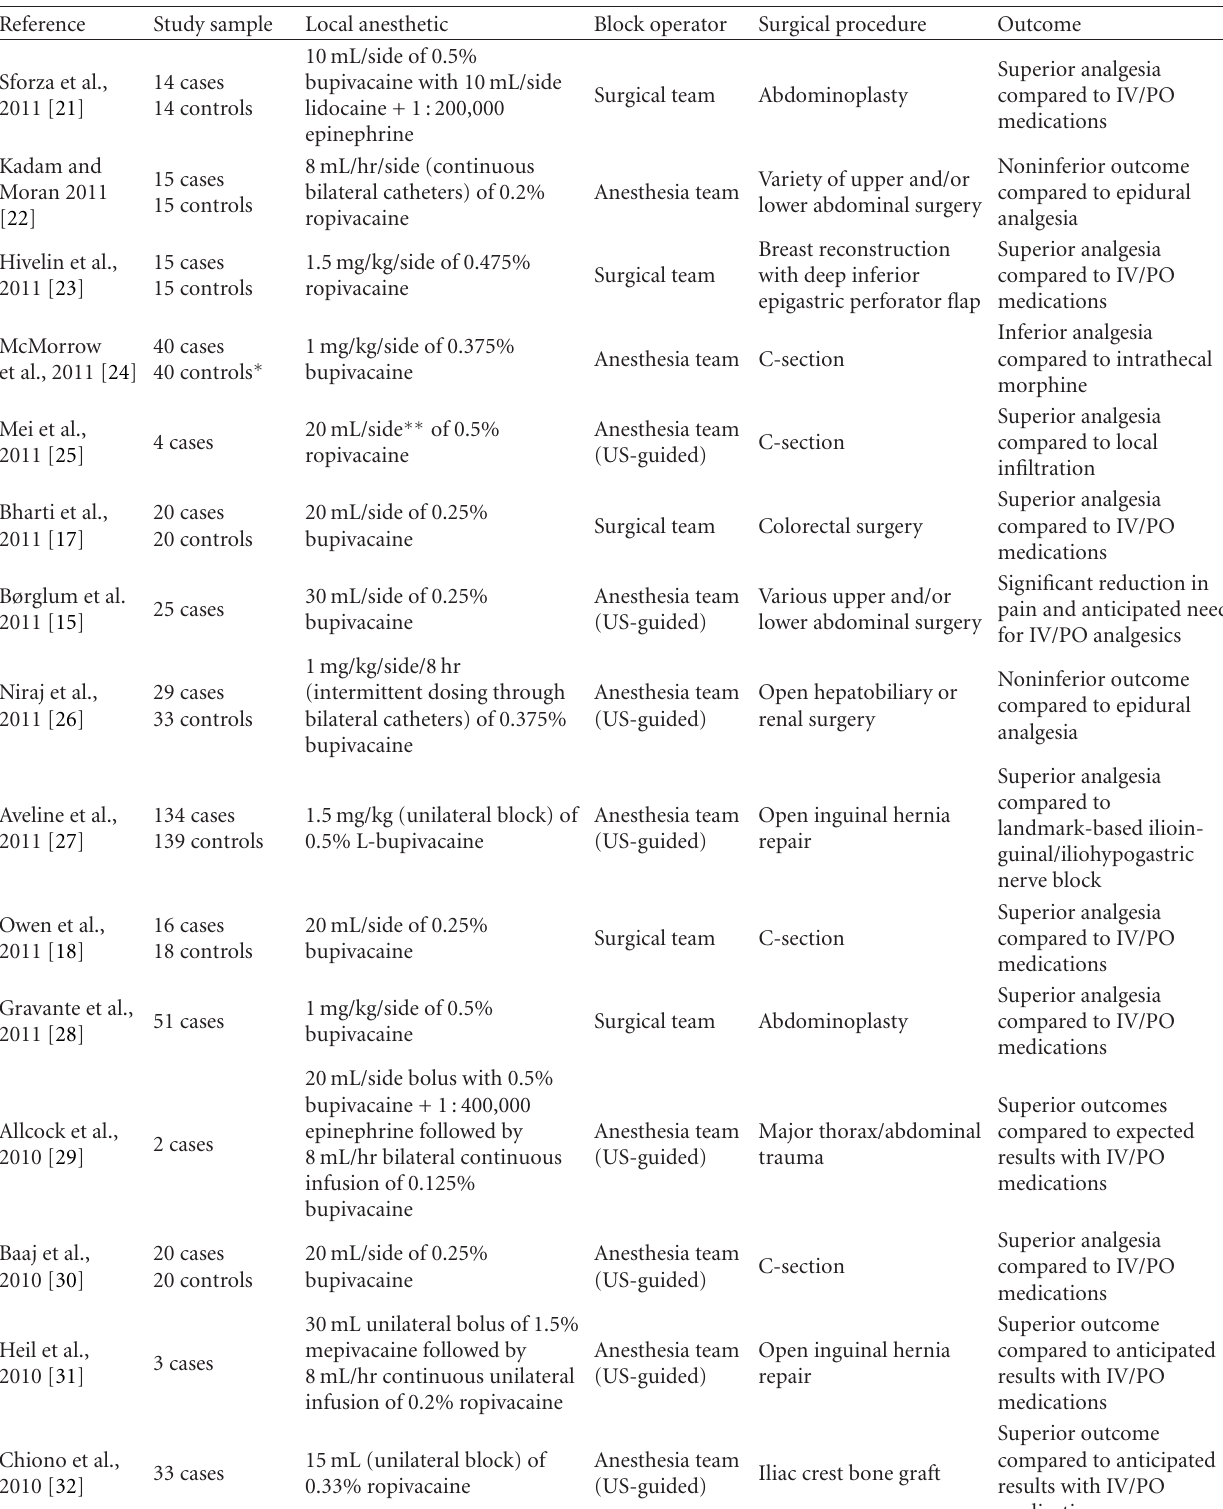
Table 1: List of published clinical studies on the use of TAP blocks. Single patient case reports have been excluded. ( ∗ ) 20 patients were randomized to receive TAP block and spinal block with plain bupivacaine, while 20 patients were randomized to receive TAP block, bupivacaine spinal block, and intrathecal morphine. ( ∗∗ ) Volume includes some local anesthetic used to perform ilioinguinal block in conjunction with TAP block. US-guided: ultrasound-guided. L-bupivacaine: